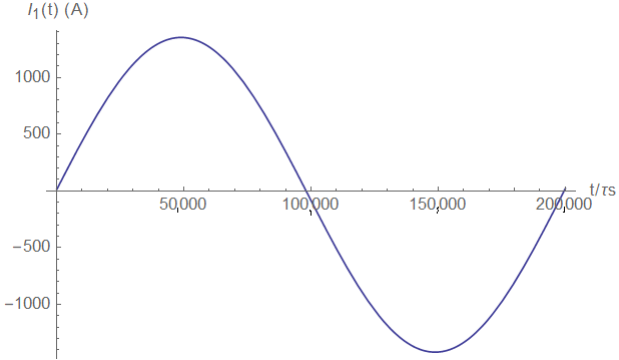
Figure A18. Source current a long time after the short.